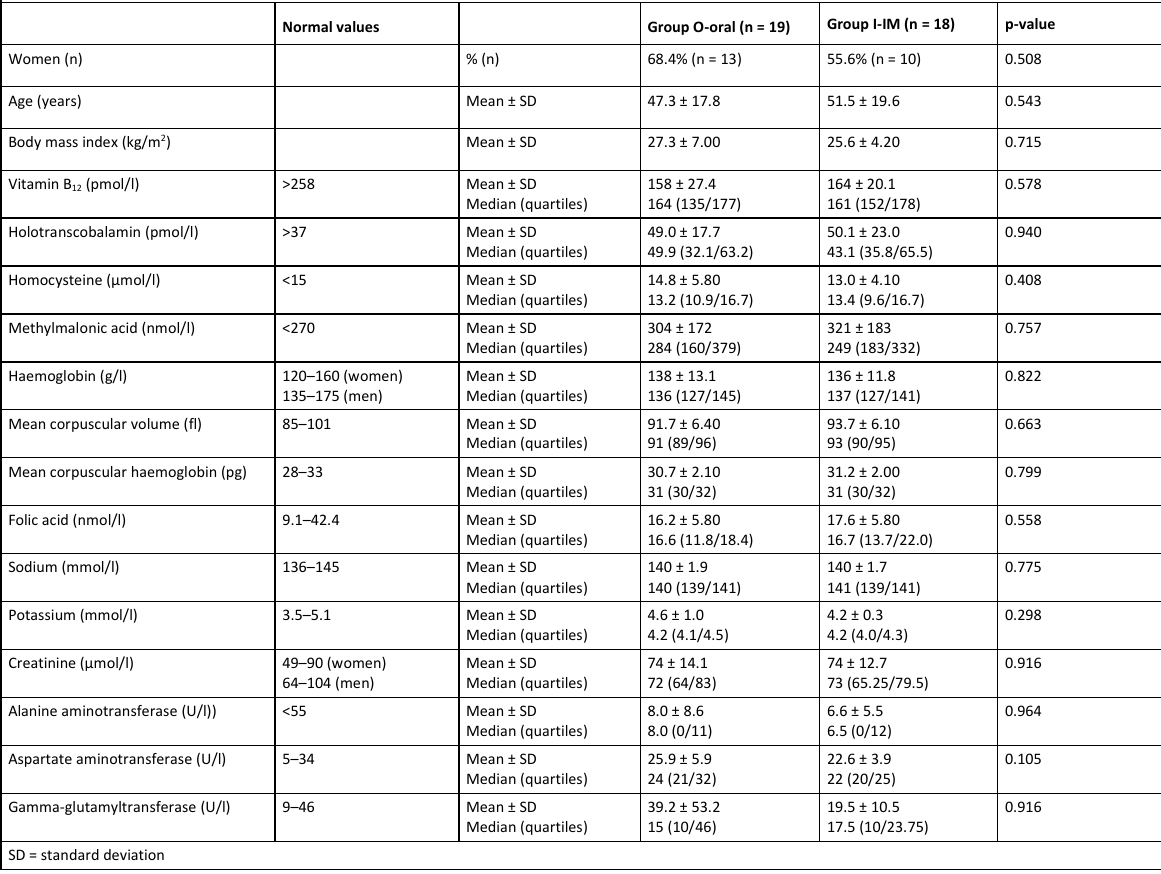
Table 1: Baseline characteristics in patients receiving oral or IM vitamin B 12 substitution (n = 37).